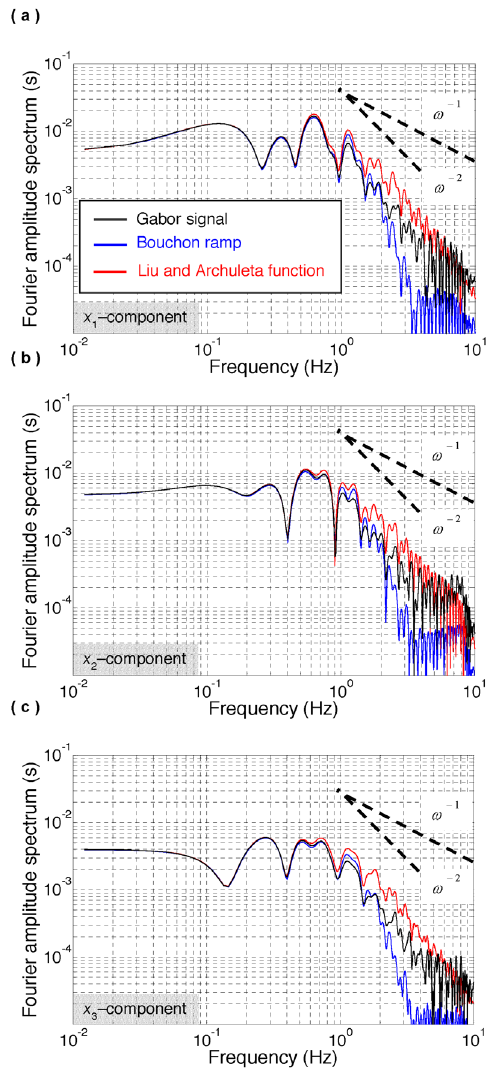
Figure 5. The same as Figure 4, but now for the time histories plot- ted in Figure